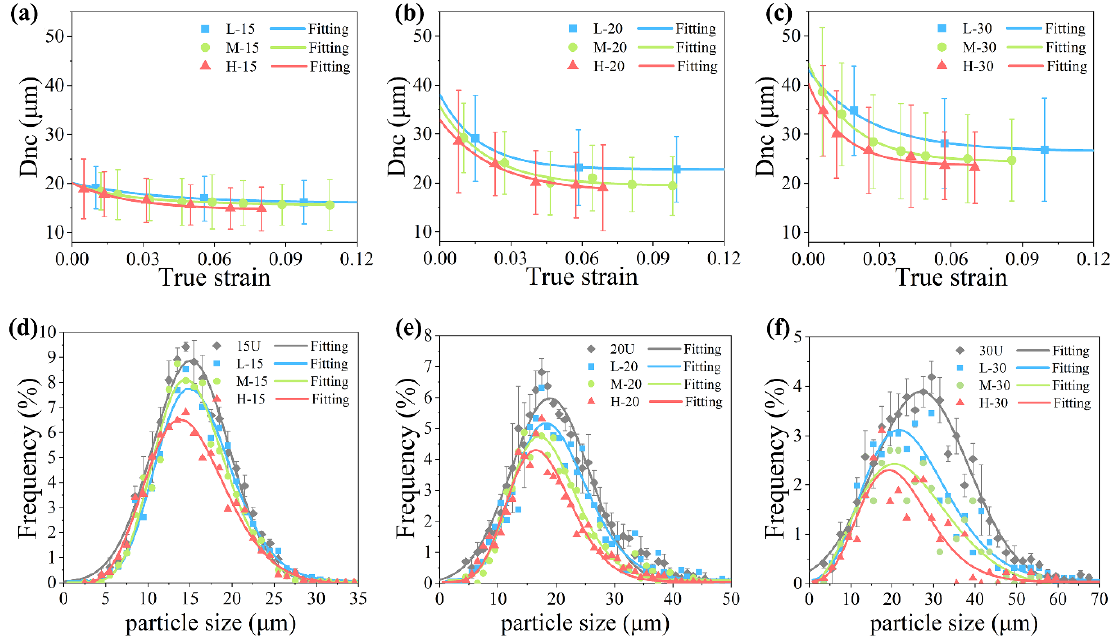
Figure 5. The diameter of new cracked particle (Dnc) in composites with particle sizes of ( a ) 15 μm, ( b ) 20 μm, and ( c ) 30 μm. The error bars of Dnc show the diameter deviations of Dnc in every strain step. As well as the size distribution of particles before loading (xxU) and their survived particles after fracture in composites with particle sizes of ( d ) 15 μm, ( e ) 20 μm, and ( f ) 30 μm. The error bars of the xxU show the frequency deviations in each particle size.